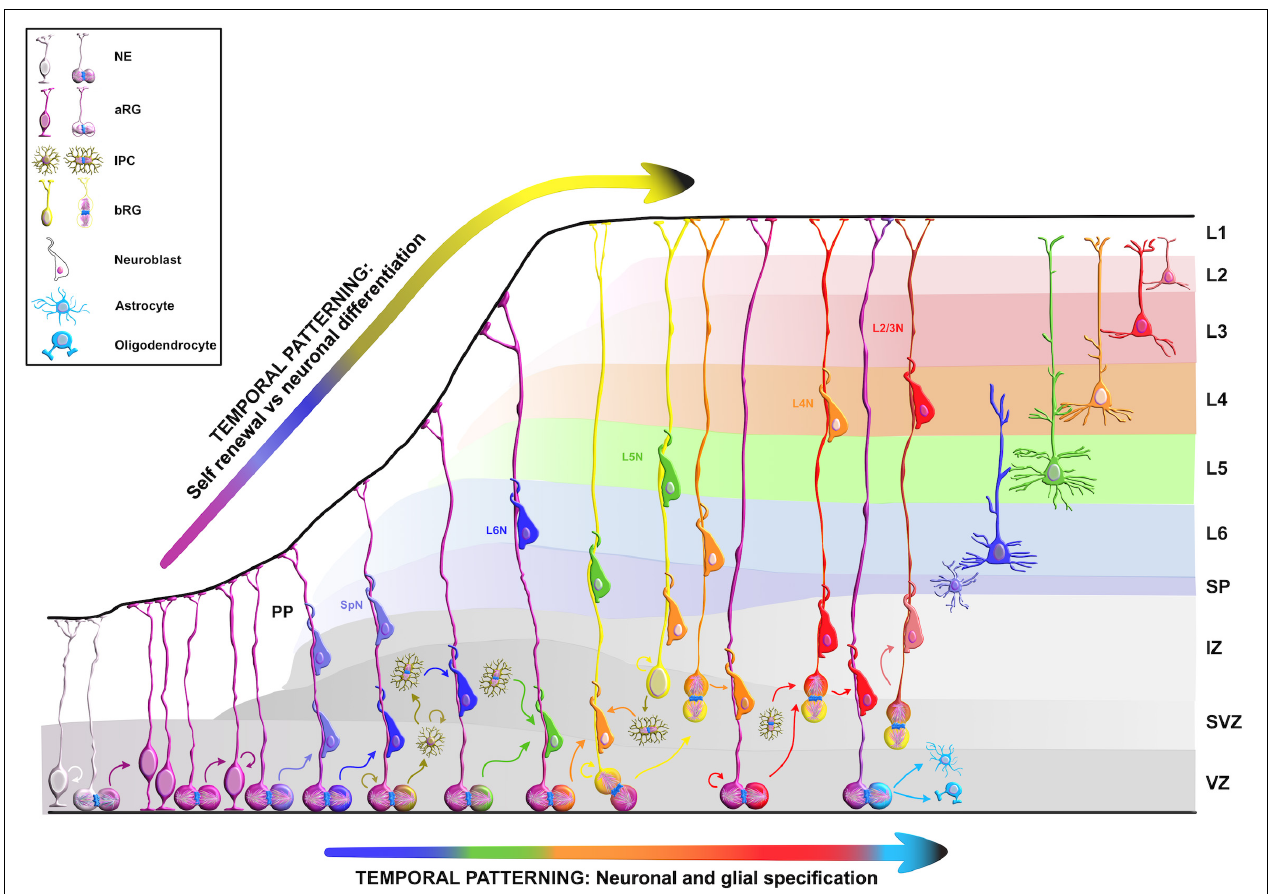
FIGURE 2 | Temporal molecular patterning during neocortical development. The development of the mammalian neocortex can be conceptualized through the evolutionarily conserved mechanism of temporal molecular patterning. Molecular patterning of apical progenitors along two temporal branches provide an overview of the intrinsic processes that guide one of the two fate transitions that apical radial glia (aRG) undergo as neurogenesis proceeds: (1) “self-renewal vs. neuronal differentiation,” which gives rise to neuronal progeny either directly or indirectly through the generation of basal progenitors, and (2) “neuronal and glial specification,” which begins with the sequential production of layer-specific neuronal subtypes, and finishes with the generation of glial progeny during late stages of corticogenesis. NE, neuroepithelial cell; aRG, apical radial glia; IPC, intermediate progenitor cell; bRG, basal radial glia; PP, preplate; VZ, ventricular zone; SVZ, subventricular zone; IZ, intermediate zone; SP, subplate; SpN, subplate neuron; L1–L6, layers 1–6; L2/3N-L6N, layer 2/3 neuron-layer 6